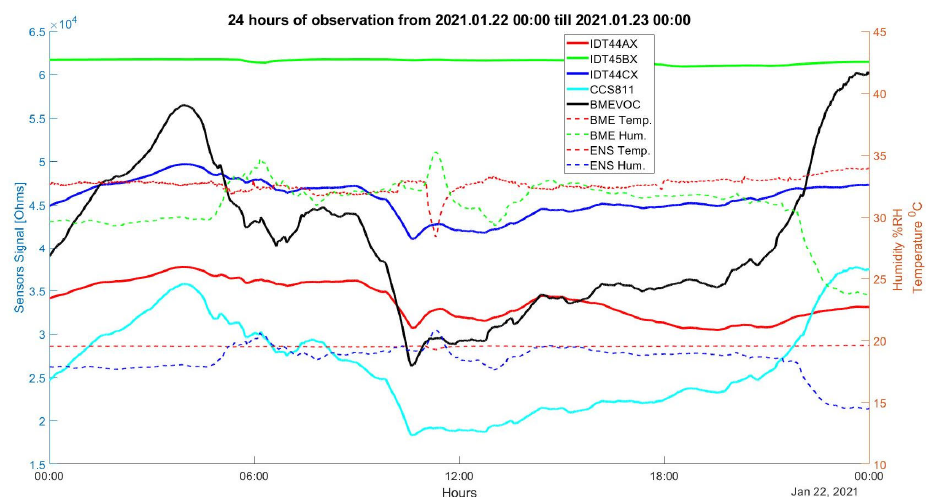
Figure 6. Environmental BME and ENS sensors, and gas sensor signals taken from a patient in the mechanical lung ventilation machine for 24 h of measurements.